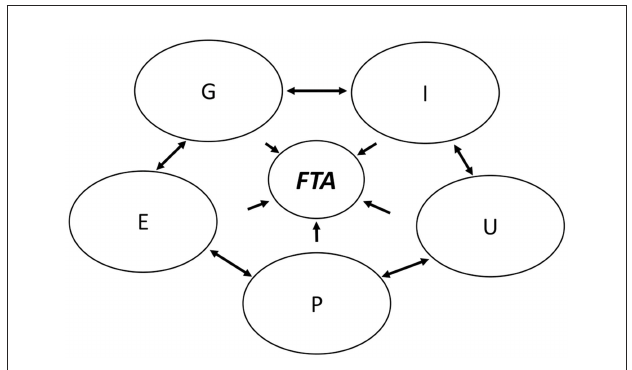
FIGURE3 A quintuple helix model for foresight. Source: author’s calculation. G, the political system; U, the education system; I, the economic system; P, the media-based and culture-based public; E, the natural environment; FTA, future-oriented technology